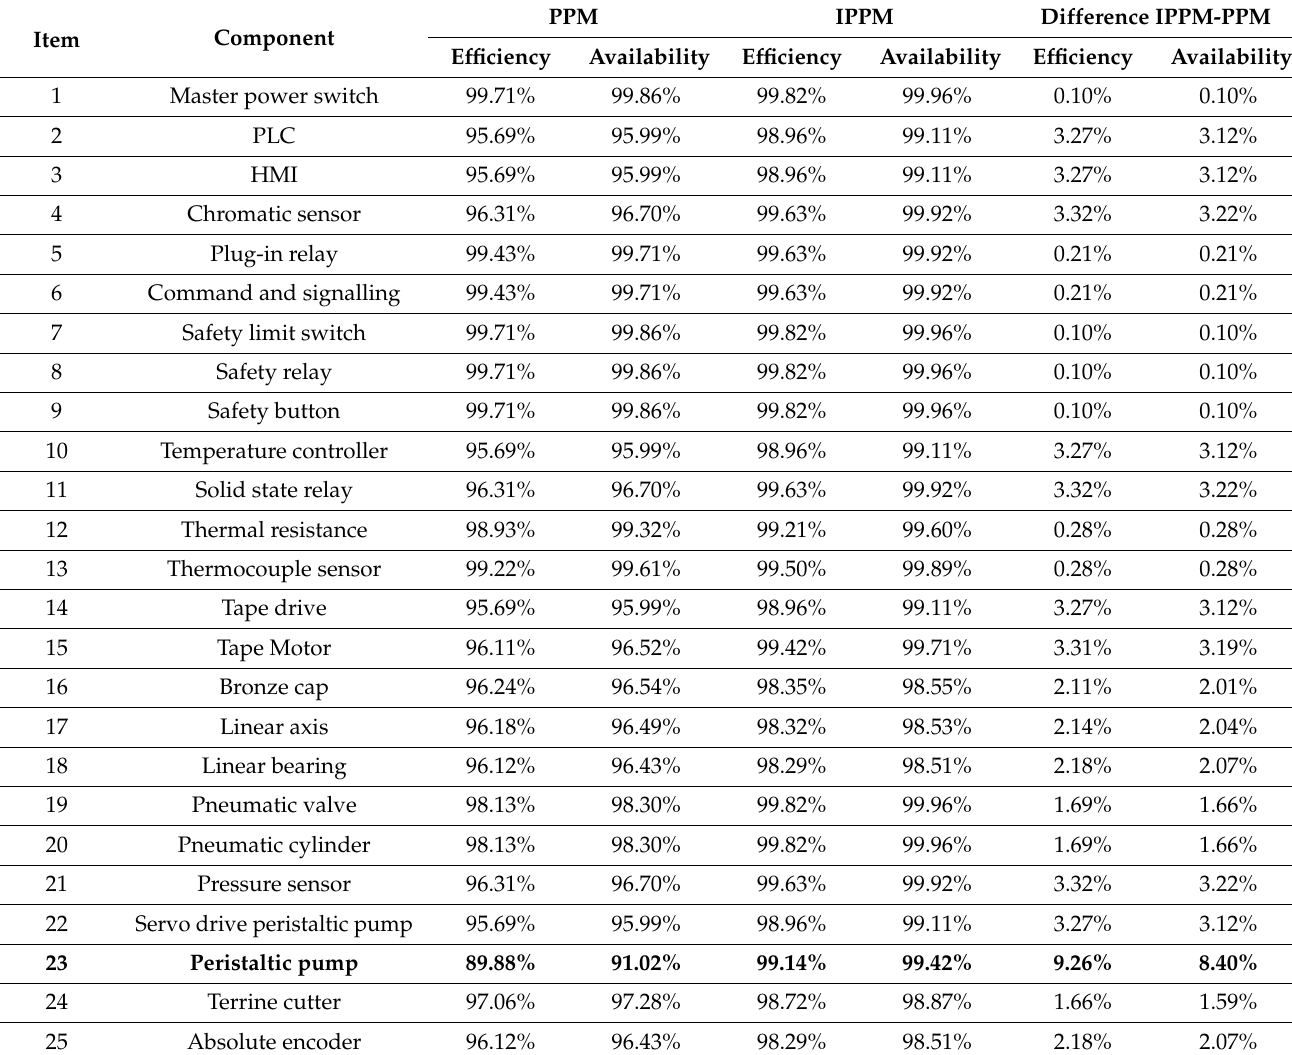
Table 3. Comparison of efficiency and availability between PPM and